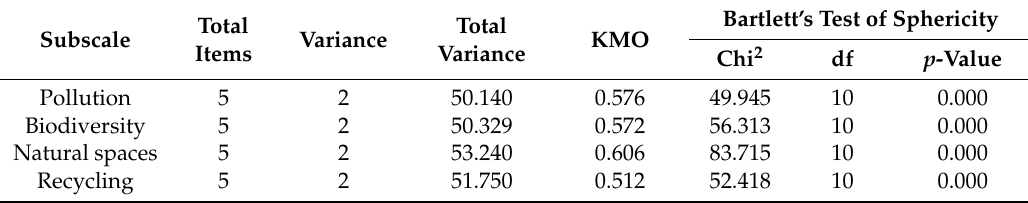
Table 1. Exploratory factor analysis by